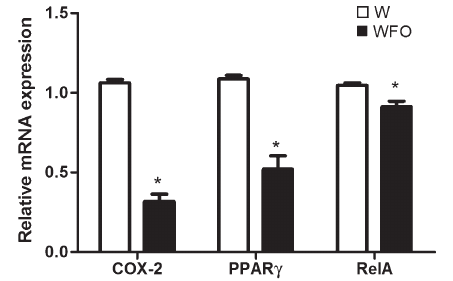
Figure 2. Relative mRNA expression of COX-2, PPAR c and RelA in tumor tissue from rats fed a regular chow diet (W) or a regular chow diet supplemented with fish oil (WFO). Fold-change compared to W was calculated using the 2 - DD CT method. Data are reported as means±SE of n=8 (W) and n=9 (WFO) rats from three independent experiments. *P , 0.05 vs W (Student t